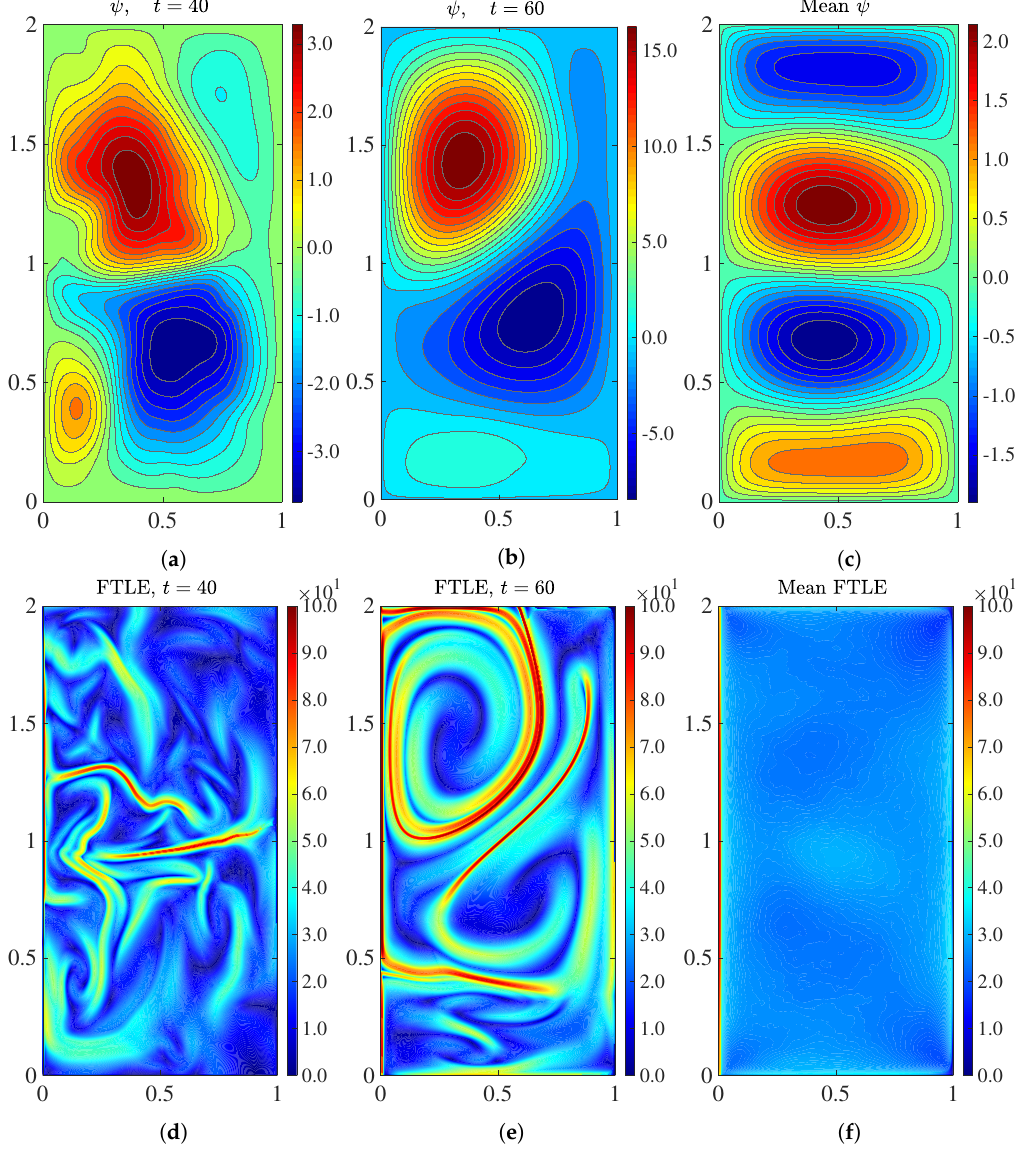
Figure 1. Streamfunction contour plots at t = 40 (plot ( a )), t = 60 (plot ( b )), and time-averaged (plot ( c )). FTLE contour plots at t = 40 (plot ( d )), t = 60 (plot ( e )), and time-averaged (plot ( f )). An FTLE movie is available at